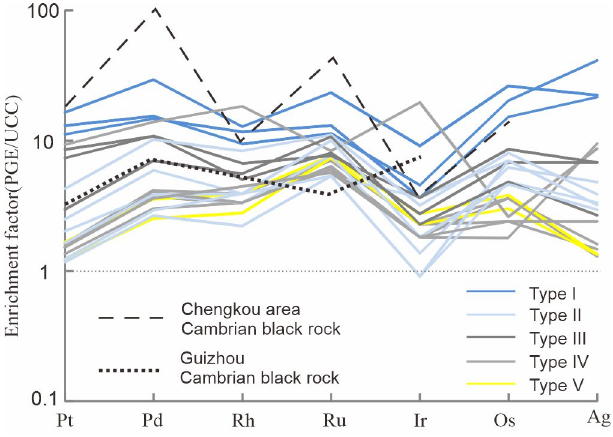
Figure 6. Enrichment factors of PGEs in the Longmaxi Fm black shale in CN outcrop normalized to the UCC [6]. Table 3. PGEs and relevant parameters of CN outcrop.